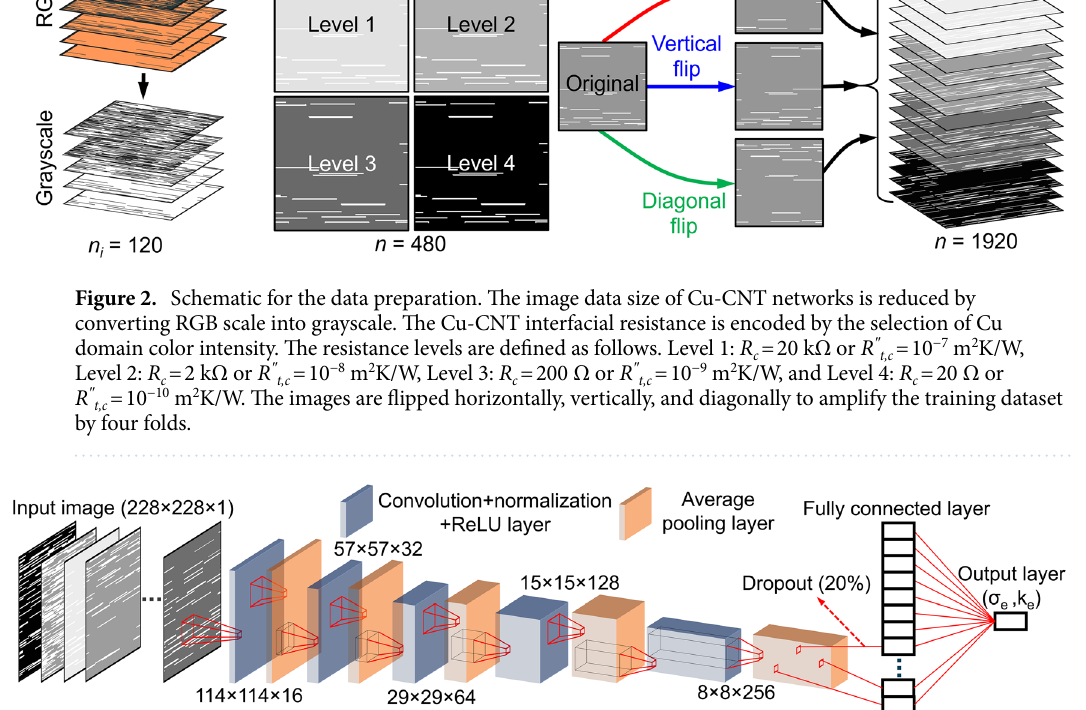
Figure 3. The architecture of CNN to approximate the effective electrical and thermal conductivities of Cu-CNT networks. σ e denotes the effective electrical conductivity and k e denotes the effective thermal